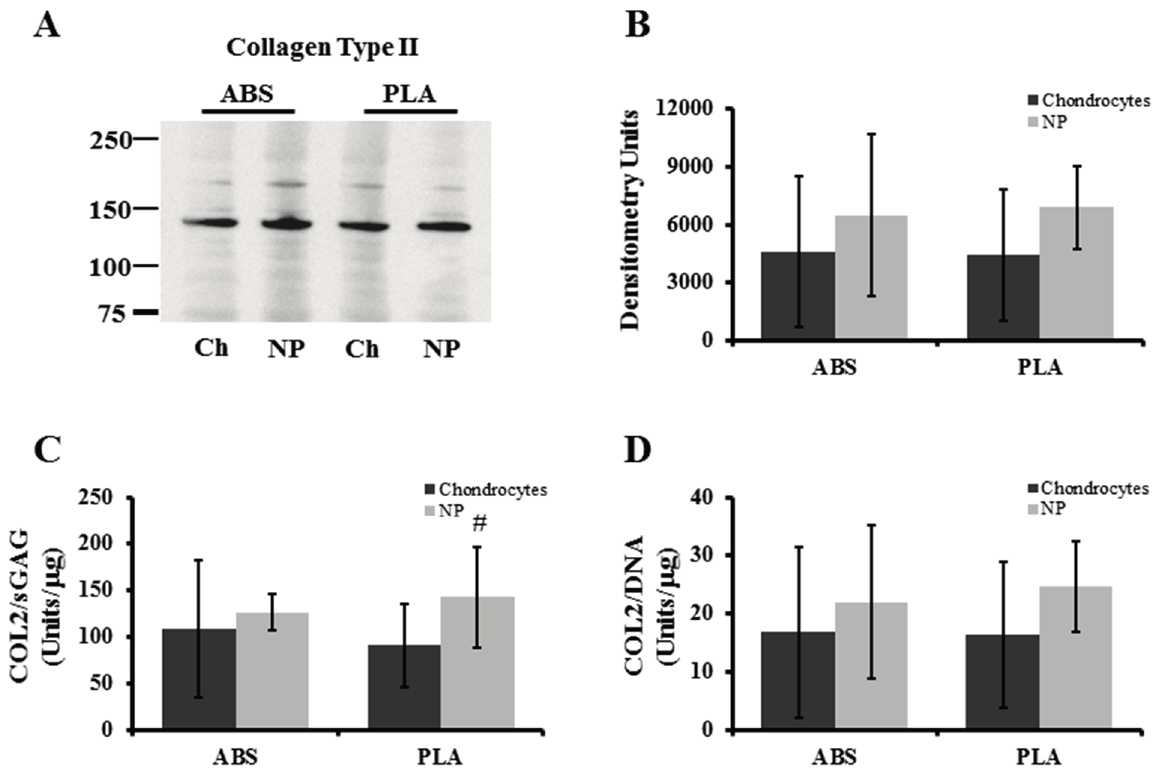
Figure 6. Collagen type II analysis of cell-seeded scaffolds. ( A ) Representative Western blot probing extracts for newly synthesized, non-crosslinked collagen type II; ( B ) densitometry quantification for collagen type II deposition on scaffolds; ( C ) extractable collagen type II band density/sGAG was determined; ( D ) extractable collagen type II band density/DNA was determined. Error bars represent ± SD. # indicates p =